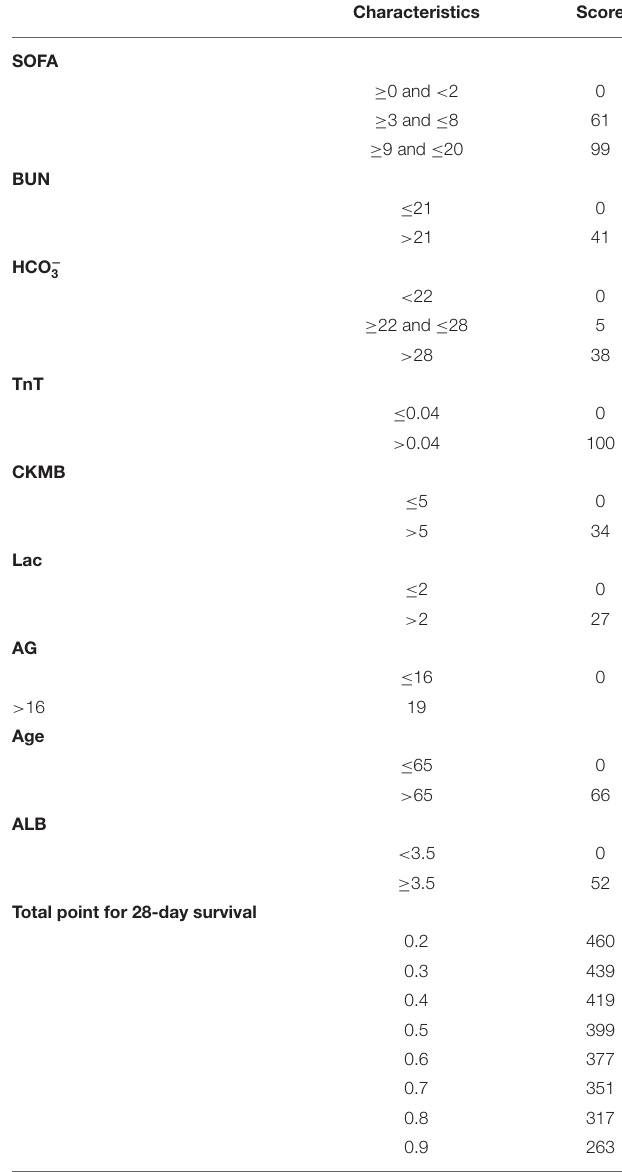
TABLE 4 | The specific value of clinicopathological factors in the nomogram of the training cohort.